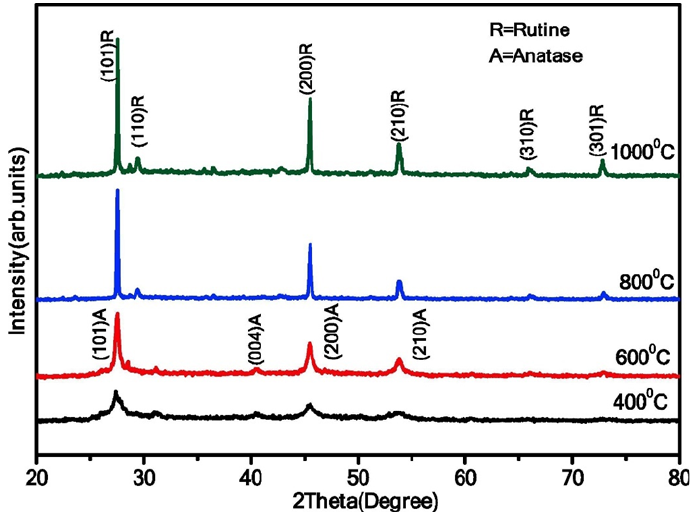
Figure 12. XRD analysis of TiO 2 NPs synthesized at varying annealing temperatures ( 400 °C, 600 °C, 800 °C, and 1000 °C). Reprinted from [33].